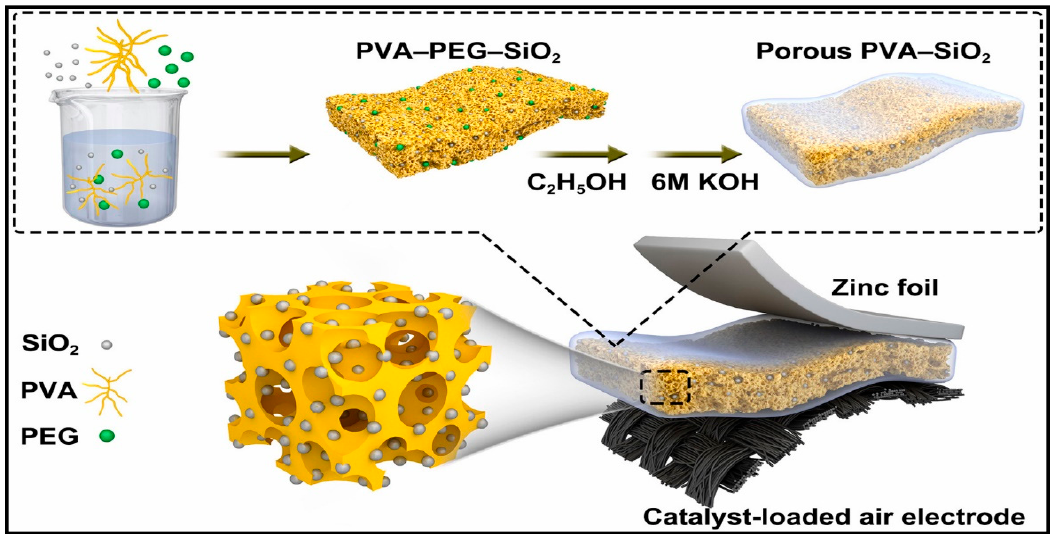
Figure 5. Schematic diagram of the flexible ZAB and preparation process of the porous PVA-based nanocomposite GPE along with its inner structure. Reproduced with permission from [146]. Copyright 2019 Elsevier.